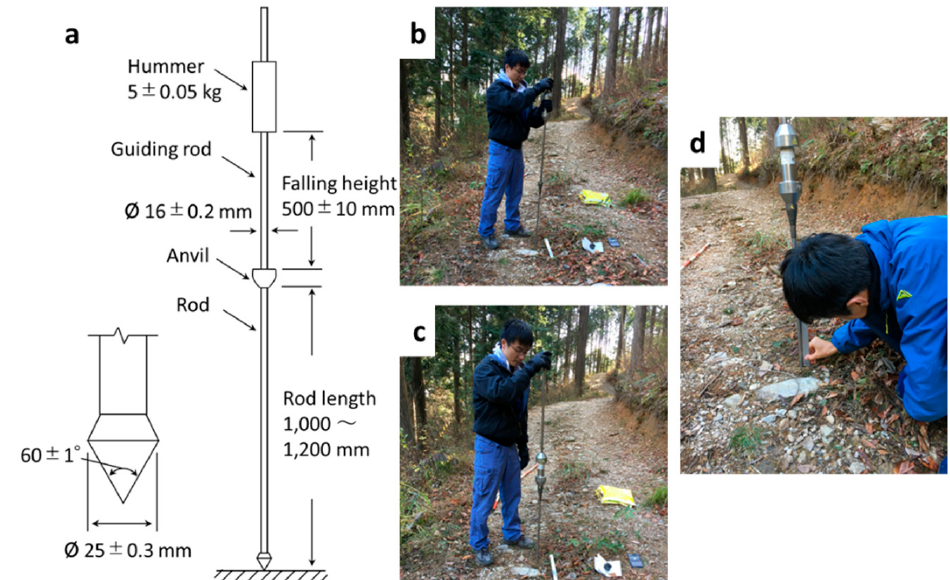
Figure 4. Doken-type dynamic penetrometer. Standardized design of the Doken-type dynamic penetrometer ( a ) (the Japan Geotechnical Society, Committee for Standard of Geotechnical Survey 2014 [36]). The soil strength is measured by striking the hammer at a height of 500 mm ( b – d ) with the road kept vertical. By measuring the penetration depth by each strike or a few strikes, the penetrated depth is converted into an N d value, which represents the number of strikes required for a depth of penetration of 10 cm.